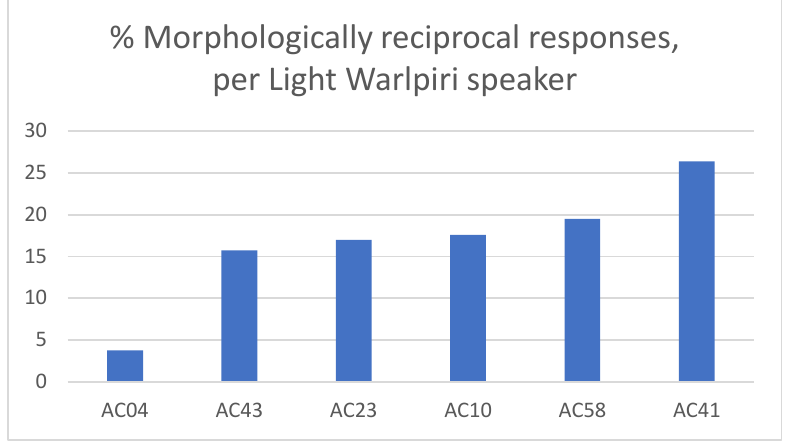
Figure 2. Percent of all morphologically reciprocal responses, per Light Warlpiri speaker.